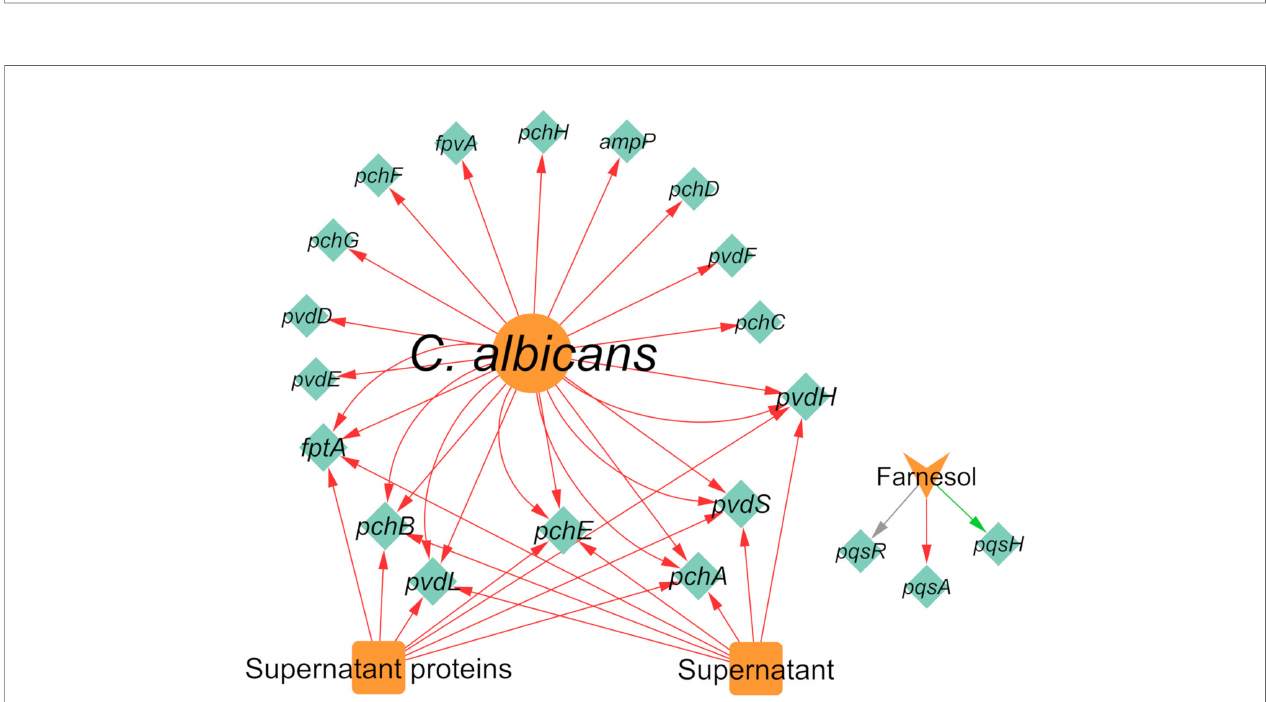
FIGURE 8 | Network of the effects of C. albicans on P. aeruginosa gene expression. Legend: Teal nodes, P. aeruginosa ; orange nodes, C. albicans ; green arrows, upregulation; grey arrows, null effect; red arrows: downregulation; node and node label sizes are directly proportional to the number of related (outward and inward) edges